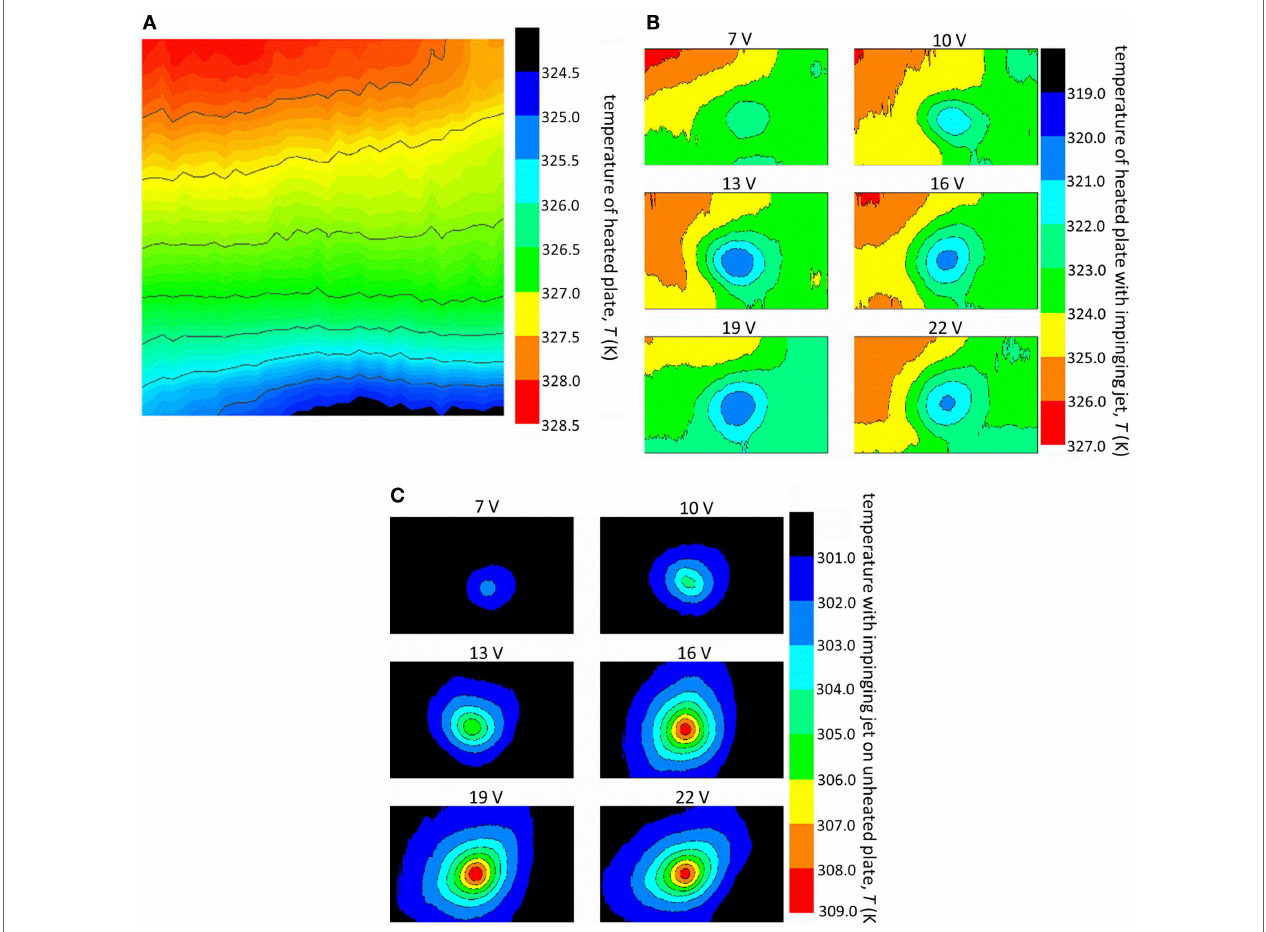
FIGURE 3 | Contours that show the temperature of (A) the heated plate without the impinging jet, (B) the heated plate with the impinging ionic wind at different PT input voltages, and (C) the unheated plate with the impinging ionic wind at different PT input voltages . The sharpened PT was positioned 1cm from the plate. All of the contours are of a viewing area that is 6cm wide and 5.4cm tall. (Please note that the contours themselves are at a slightly different height to width ratio than the viewing area, causing some objects to appear stretched.)